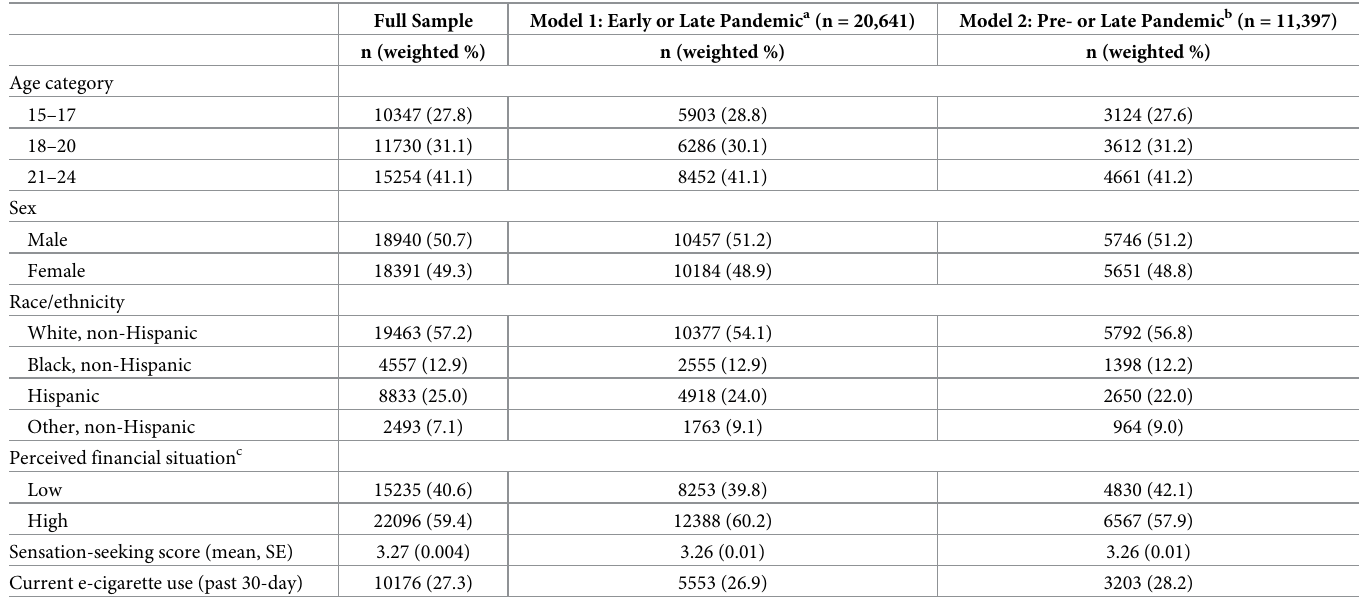
Table 1. Survey respondent characteristics, July 2019 –May 2022, United States (N =